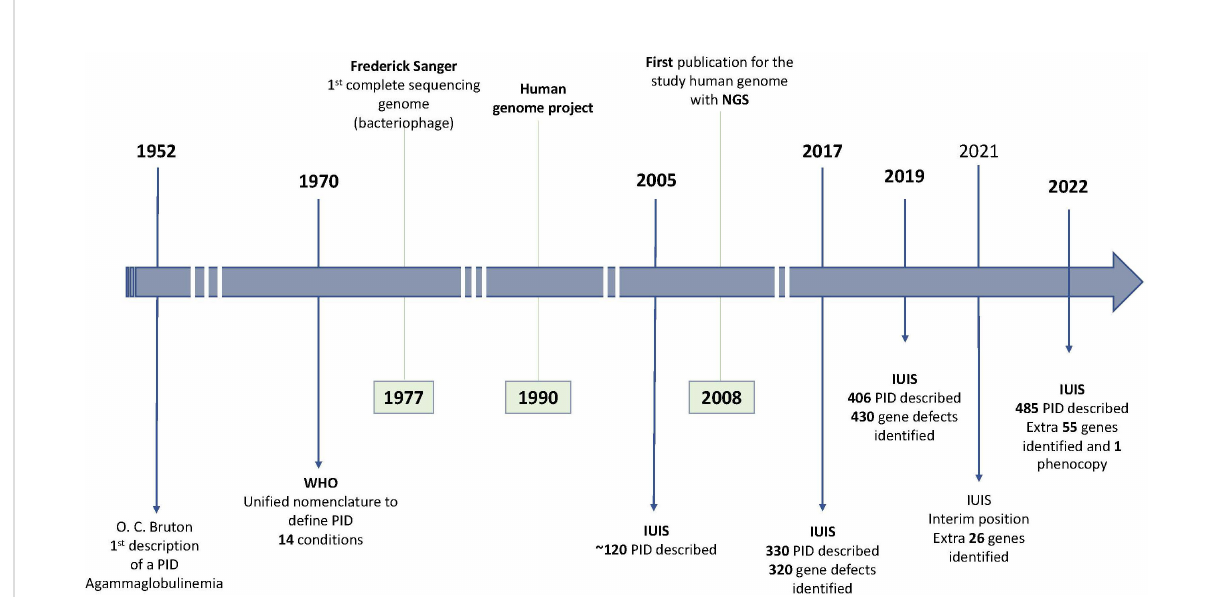
FIGURE 1 Primary Immunode fi ciencies (PID) discovery chronology and gene sequencing landmarks IUIS, International Union of Immunological Societies; NGS, Next generation sequencing; WHO, World Health